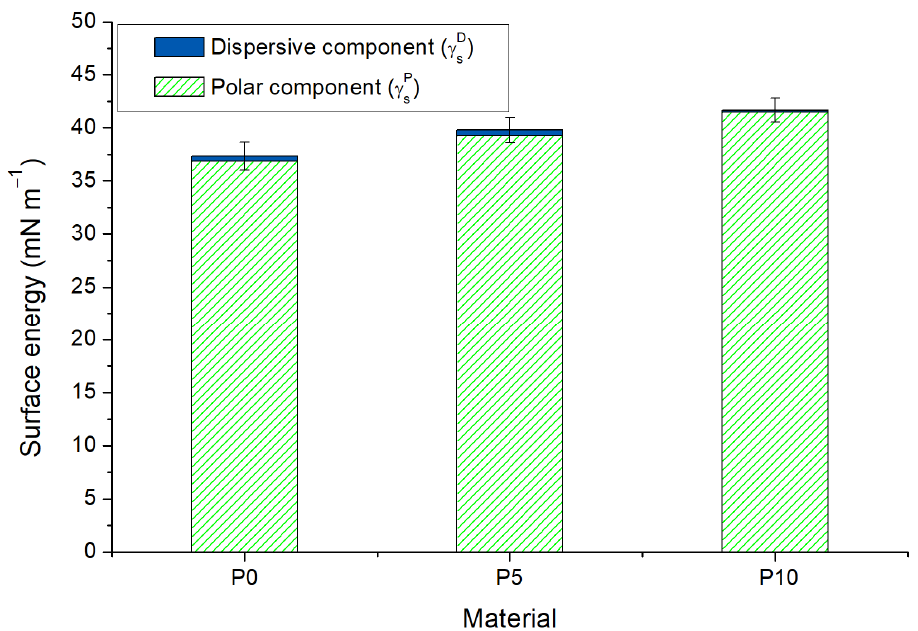
Figure 1. Surface energy and components of poly(lactic acid) (P0) and active films (P5 and P10). Error bars shows the standard deviation of total energy ( γ S ).